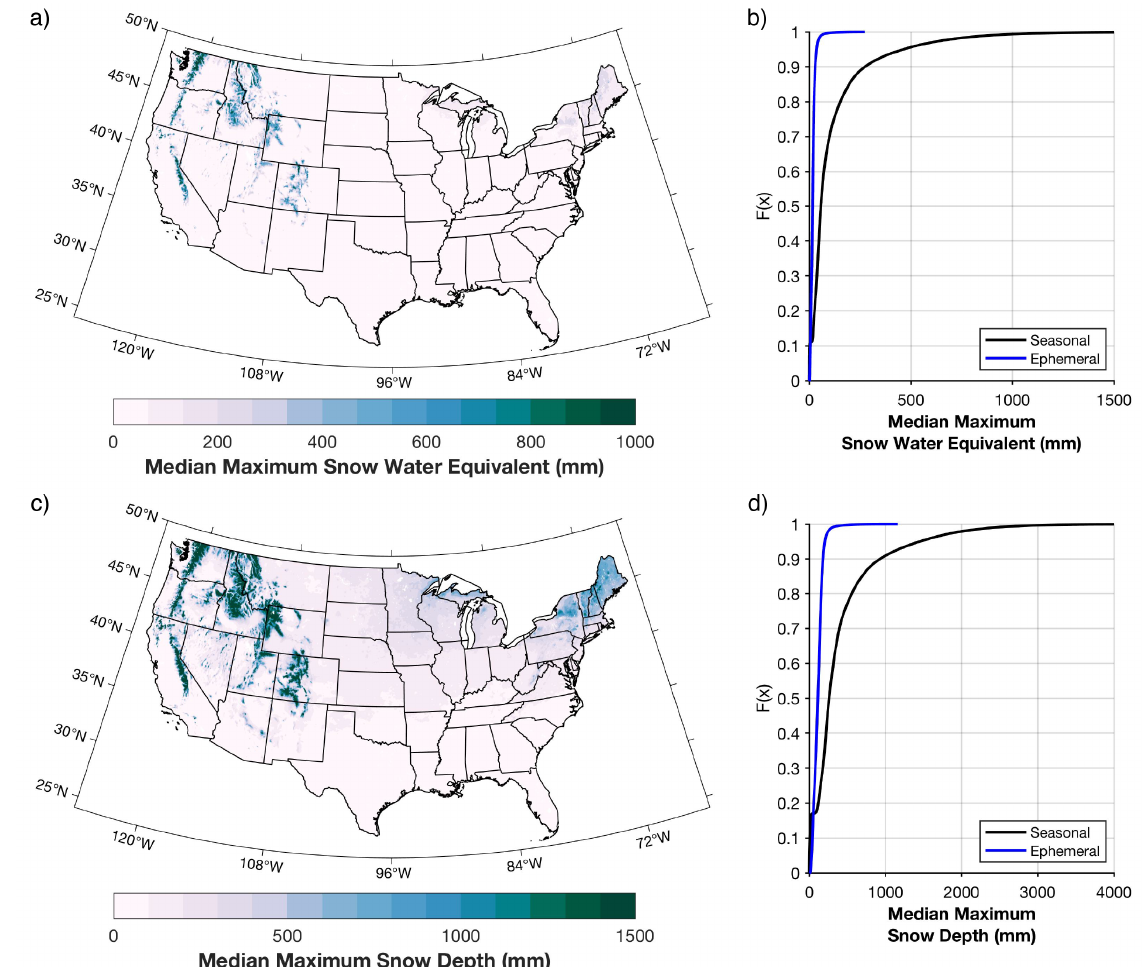
Figure 5. ( a ) Median annual maximum snow water equivalent and ( b ) the cumulative distribution functions of median maximum snow water equivalent for seasonal (black line) and ephemeral (blue line) snowpacks. ( c,d ) As in ( a,b ) but for median annual maximum snow depth.